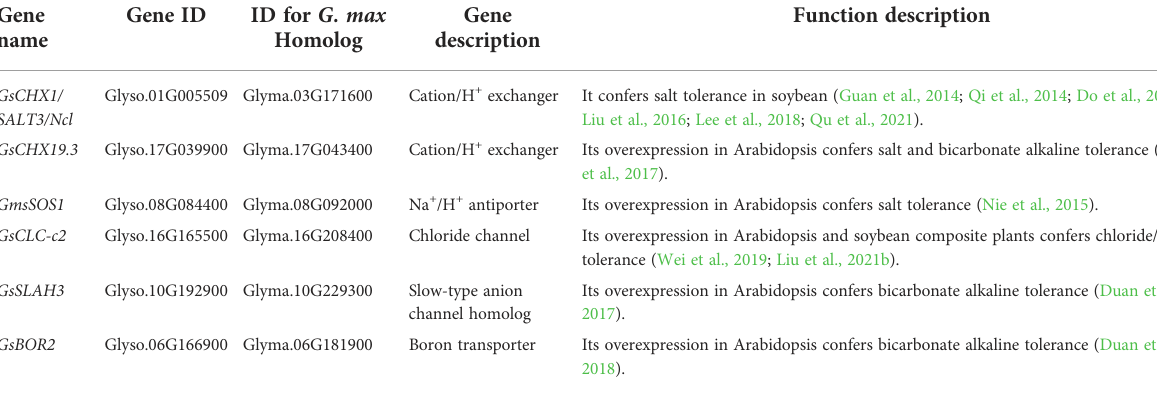
TABLE 1 Genes involved in ion balance under salt-alkaline stress in wild